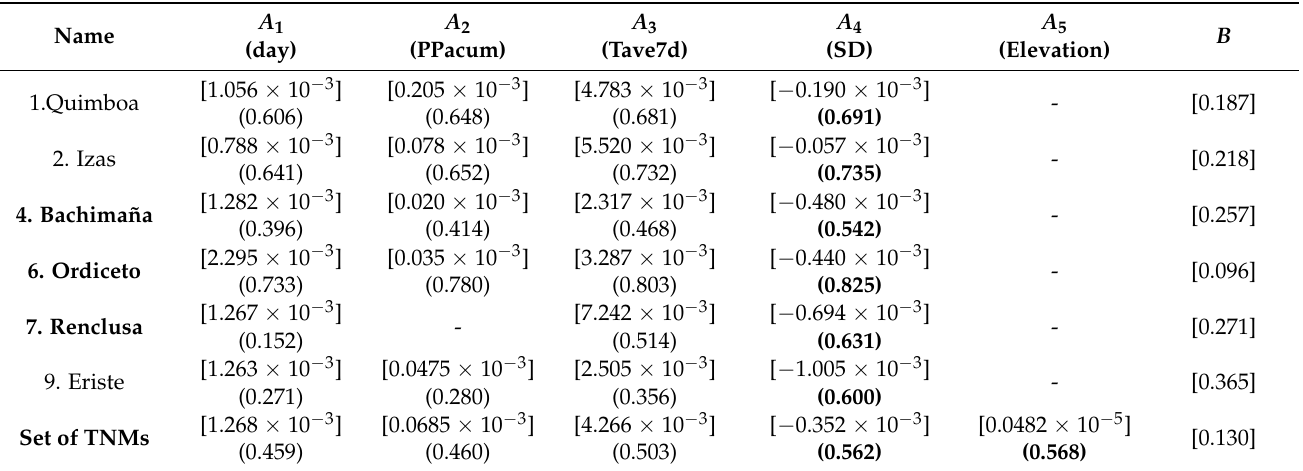
Table 9. Optimum SDEN multiple linear regression model for TNM selected sites and the set of TNMs (TNMs Nos. 1, 2, 4, 6, 7 and 9). Regression coefficients [ A i , B ] and the incrementally adjusted correlation coefficient ( R i 2 ). Bold letters are used for the final adjusted correlation coefficient ( R 2 ) for Equations (3) and